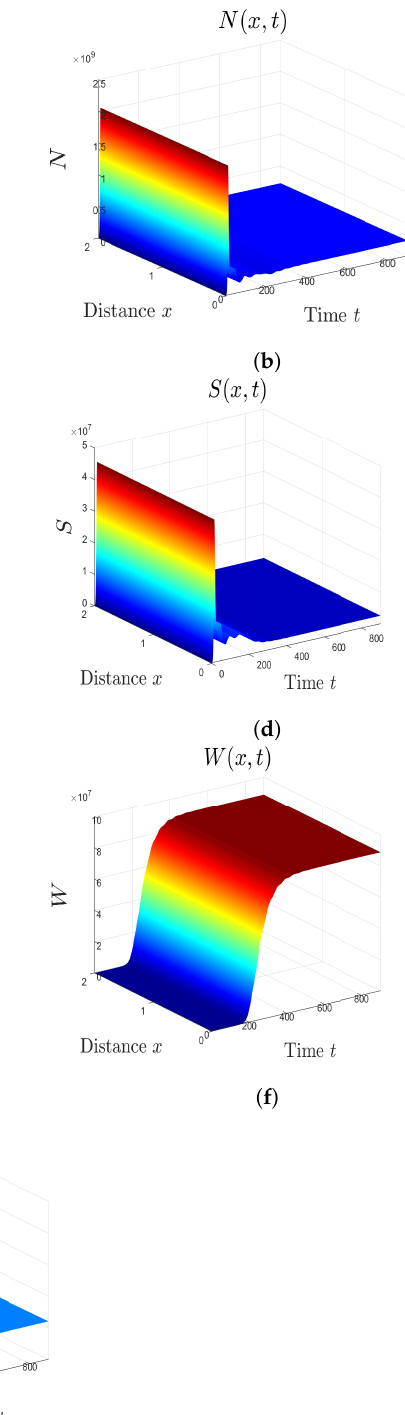
R j > 1. The coexistence R l